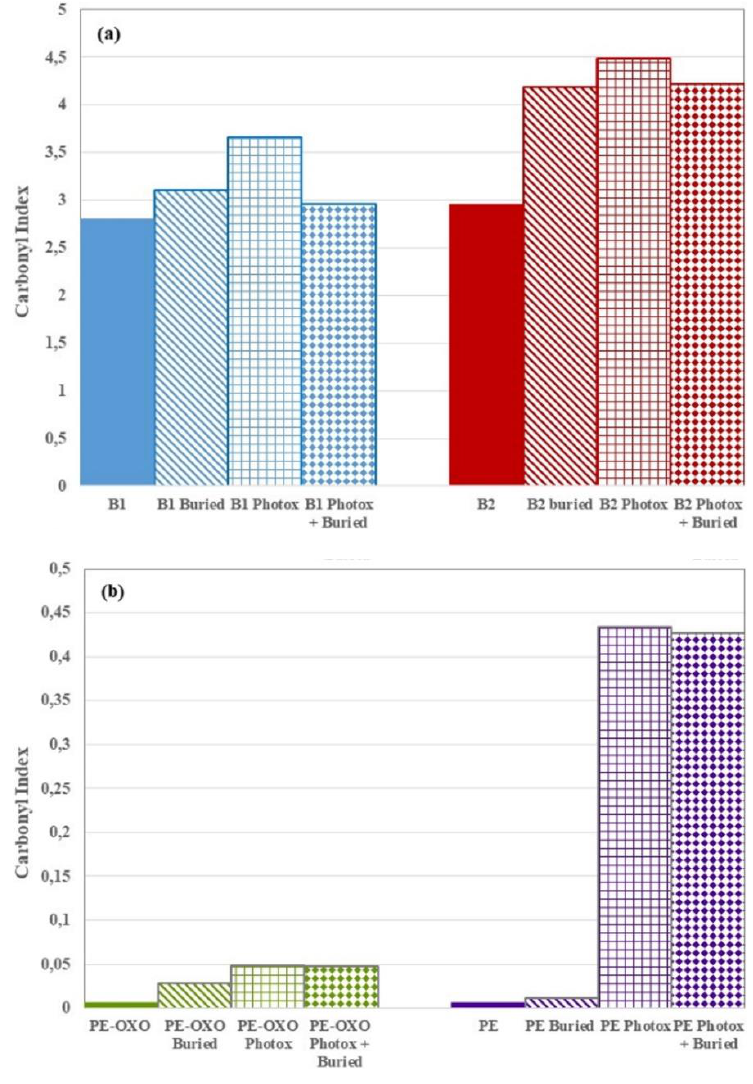
Figure 8. Carbonyl index values for ( a ) the two biodegradable and ( b ) PE based film samples. CI (B1) = A(1808 – 1550 cm − 1 )/A(3029 – 2749 cm − 1 ); CI (B2) = A(1801 – 1487 cm − 1 )/A(3029 – 2749 cm − 1 ); CI (PE and PE-OXO) = A(1826 – 1550 cm − 1 )/A(2983 – 2662 cm − 1 ). B1 = Ecovio ® -based and B2 = Mater Bi ® -based films.